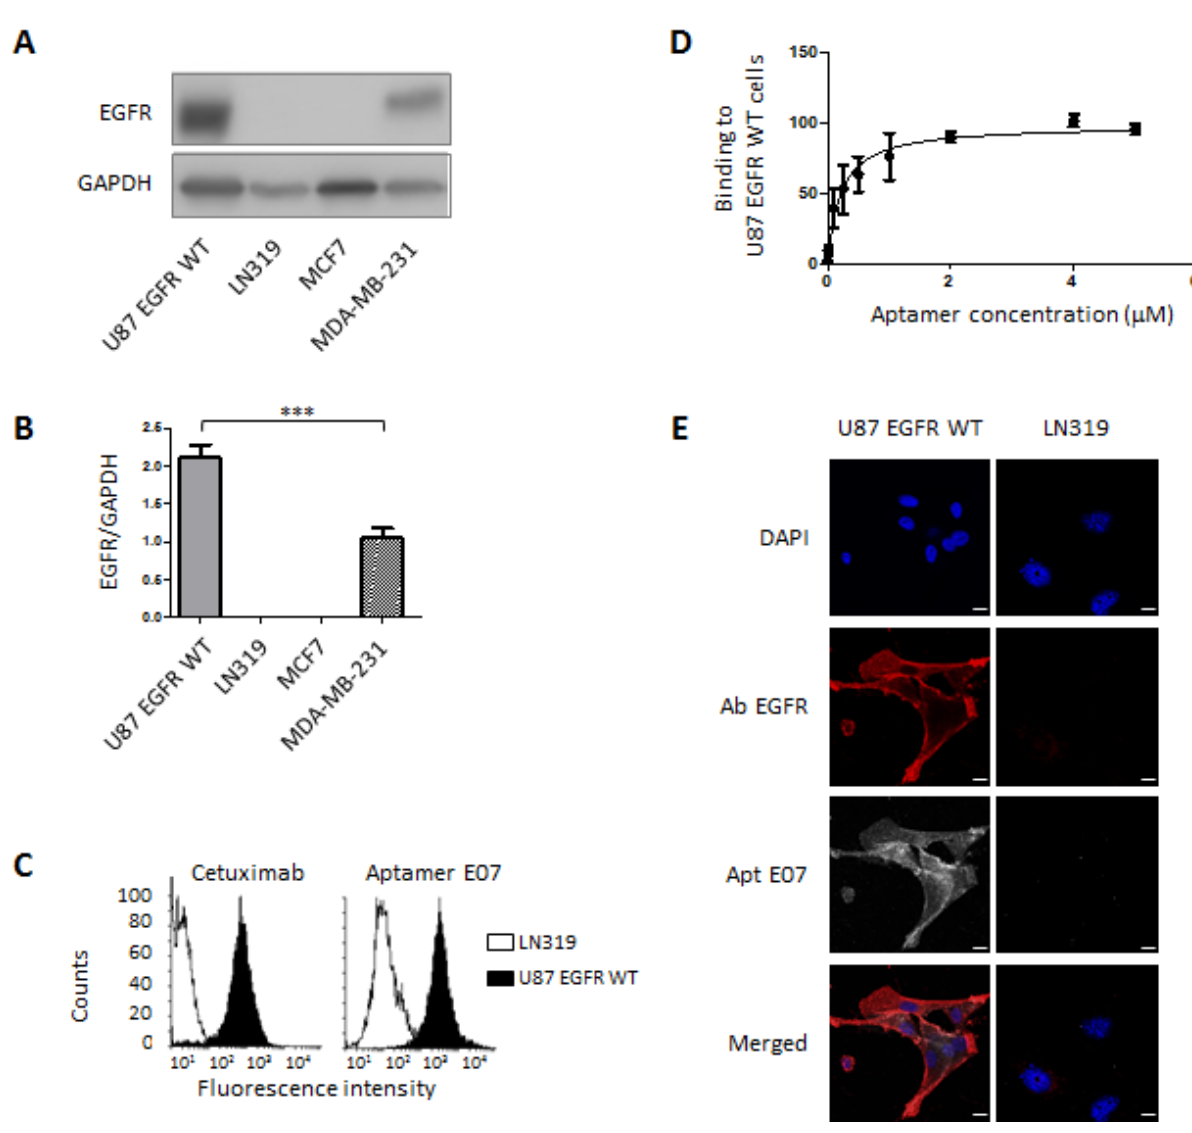
Figure 2. Validation of EGFR expression and E07 aptamer binding to cancer cells. ( A , B ) Immuno- detection of EGFR in different cancer cell lines. ( A ) Immunoblot showing the expression of EGFR (175 kDa) in U87 EGFR WT, LN319, MCF7, and MDA-MB-231 cell lines. GAPDH (37 kDa) was used as loading control. ( B ) Quantitative immunoblot analysis. Histograms represent the means ± SDs of three independent experiments normalized to GAPDH, with *** p < 0.005 (non-significant data are not specified). ( C , D ) Flow cytometry experiments. ( C ) Left side: Control of EGFR expression via the binding of EGFR antibody Cetuximab conjugated to Cy5 to U87 EGFR WT (black fill) and LN319 cells (black line, white fill). Right side: Comparison of the binding profiles of aptamer E07-Cy5 at 1 µM to U87 EGFR WT cells (black fill) and LN319 cells (black line, white fill). ( D ) Titration of aptamer E07. Different concentrations of the E07-Cy5 aptamer (0.001, 0.01, 0.1, 0.25, 0.5, 1, 2, 4, and 5 µM)